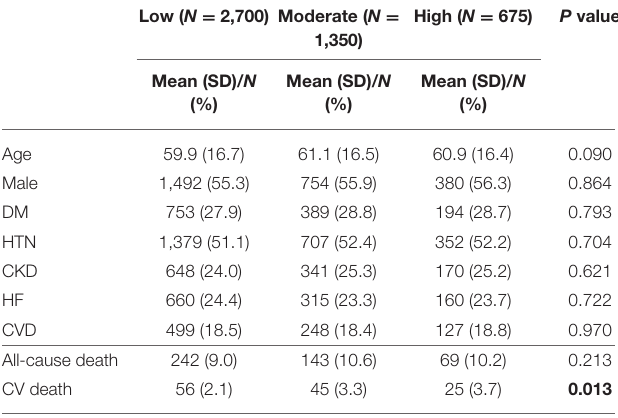
CKD, chronic kidney disease; CV death, cardiovascular death; CVD, cardiovascular disease (including coronary artery disease, stroke, and peripheral artery disease);